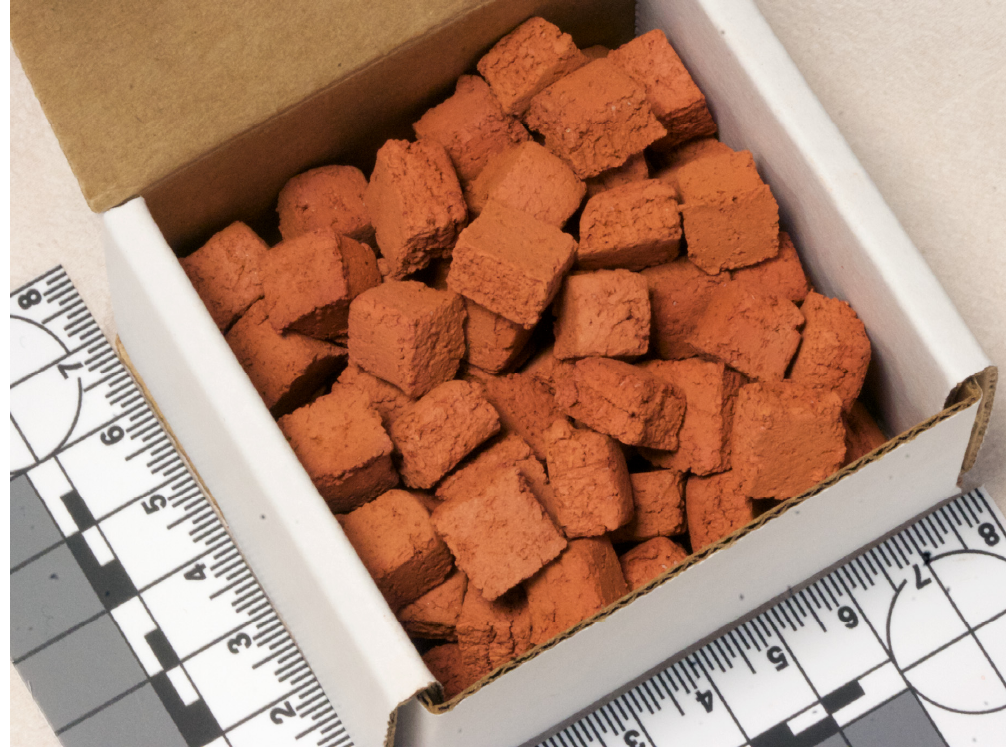
Figure 1. A single package of the silver-impregnated porous ceramic pieces used in the study. Scale shown is in centimeters (cm).